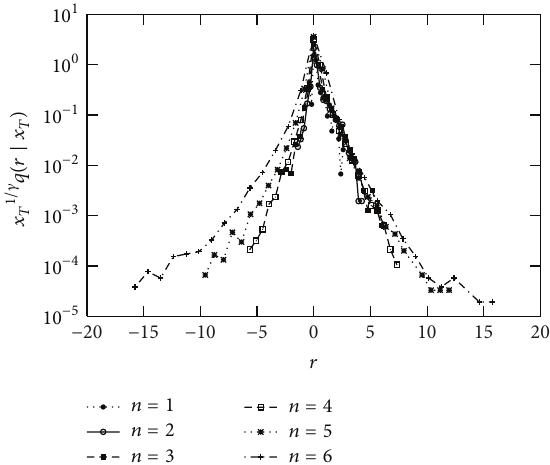
Figure 1: Conditional PDFs 𝑞(𝑟 | 𝑥 𝑇 ) of logarithmical sales growth rate 𝑟 = log 10 𝑥 𝑇+1 /𝑥 𝑇 in logarithmically equal-sized bins 𝑥 𝑇 ∈ [10 0.5(𝑛−1) ,10 0.5𝑛 ] ((a) 𝑛 = 1, 2, .. ., 6 ; (b) 𝑛 = 7,8,...,12 ) of Japanese firms in ORBIS database. Here, 𝑥 years 𝑇 = 2007 in thousands of US dollars.